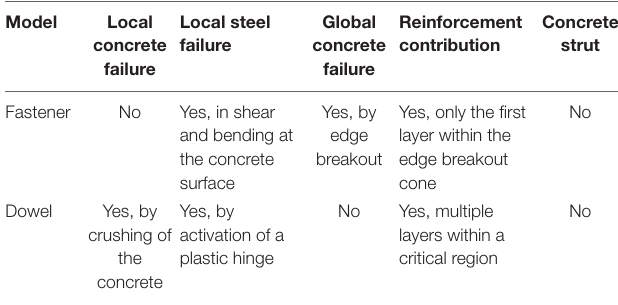
TABLE 1 | Main features of the “fastener” and “dowel”